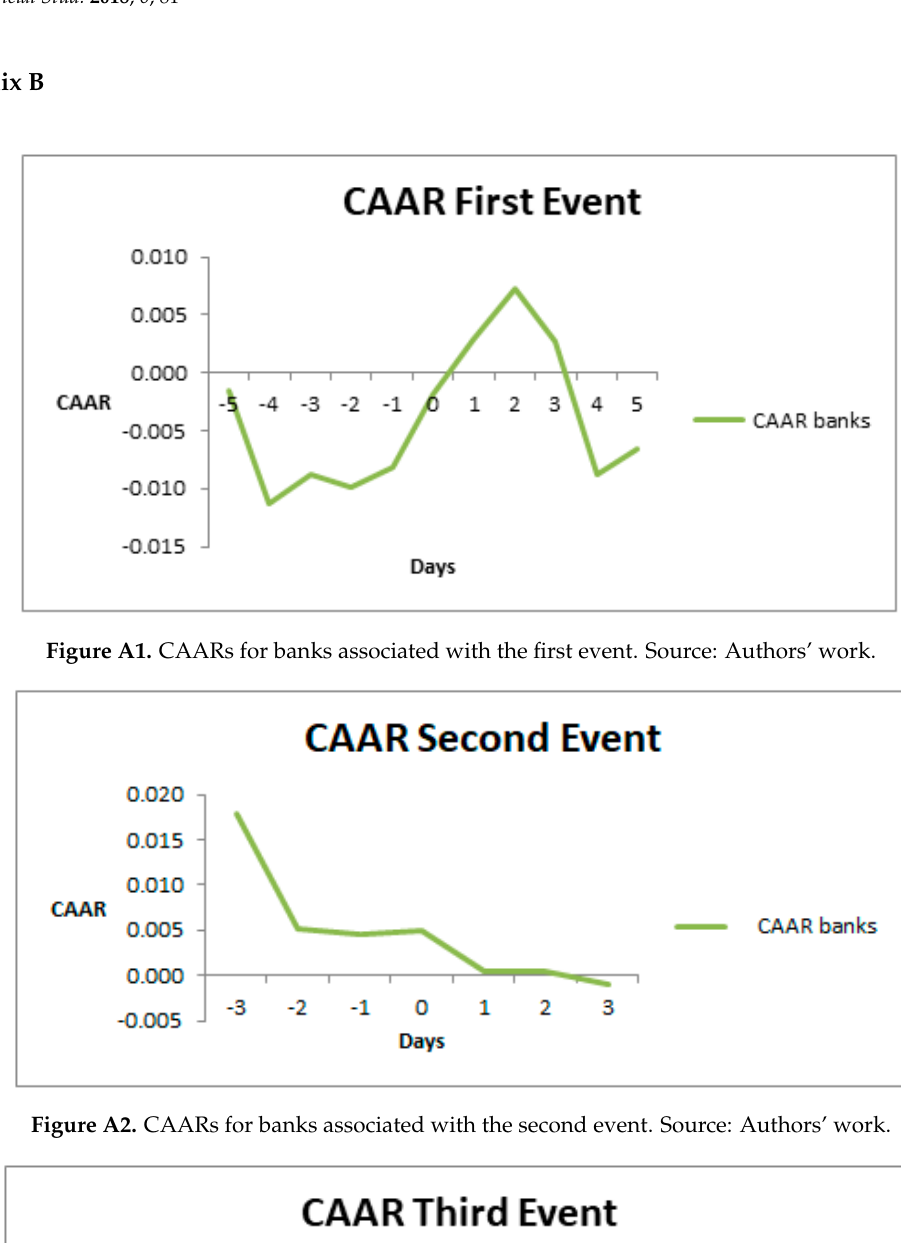
Figure A2. CAARs for banks associated with the second event. Source: Authors’ work.